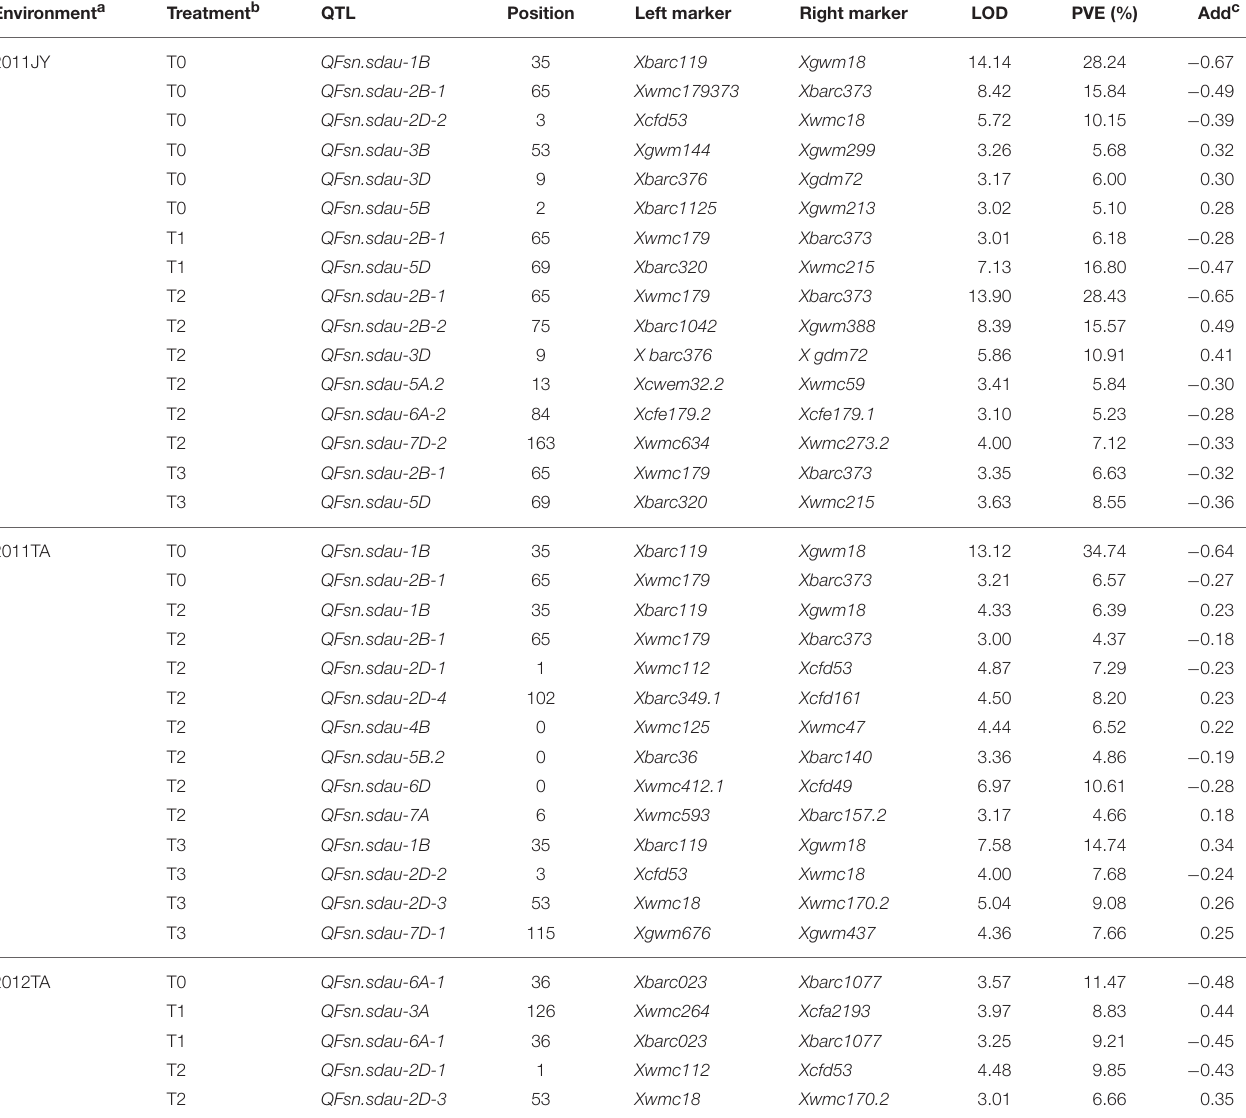
TABLE 6 | Additive QTLs for fertile spikelet number identified under different nitrogen supply dates in different years. Environment a Treatment b QTL Position Left marker Right